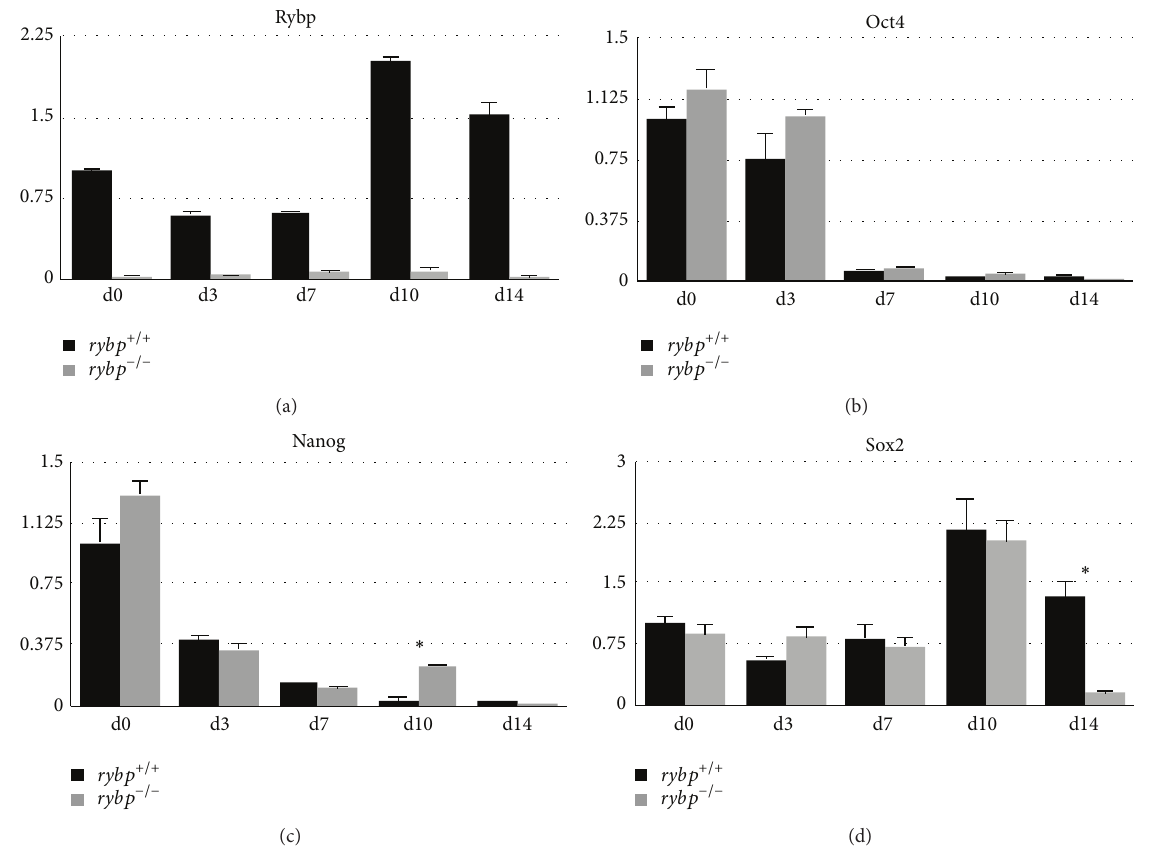
Figure 2: In the lack of Rybp there is no change in silencing of key pluripotency markers (Oct4, Nanog) during in vitro neural differentiation. Relative gene expressions of Rybp (a), Oct4 (b), Nanog (c), and Sox2 (d) were analyzed by qRT-PCR. For the analysis RNA was extracted and reverse-transcribed from differentiated neural cell culture generated from 𝑟𝑦𝑏𝑝 +/+ and 𝑟𝑦𝑏𝑝 −/− ESCs. Samples are collected at days 0, 3, 7, 10, and 14 of differentiation. The expression of the indicated markers was normalized to Hprt expression, which was used as an internal control. Means are standard deviation. Values of 𝑃 < 0.05 were accepted as significant ( ∗ 𝑃 < 0.05 ; ∗∗ 𝑃 < 0.01 ; ∗∗∗ 𝑃 < 0.001 ). Statistical method: 𝑡 test type